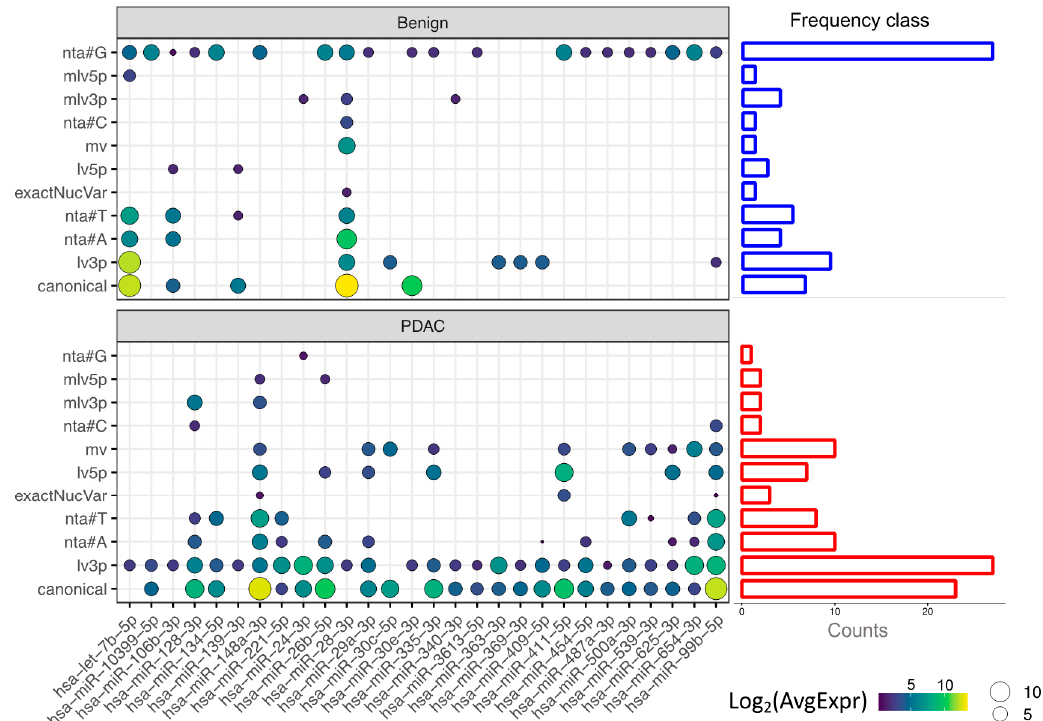
Figure 6. Heatmap of differentially expressed miRNAs and their average expression log 2 transformed in benign (upper panel) and PDAC platelets (bottom panel) following the type of isomiR: (i) canonical; (ii) length variant in 3 ′ ; (iii) non- templated addition of base A; (iv) non-templated addition of base T; (v) exact nucleotide variant; (vi); length variant in 5 ′ (vii) multiple variant; (viii) non-templated addition of base C; (ix) multiple variant in 3 ′ ; (x) multiple variant in 5 ′ ; (xii) non-templated addition of base G. Side barplots represent the frequency of the isomiR class in benign platelets (blue) and PDAC platelets (red).